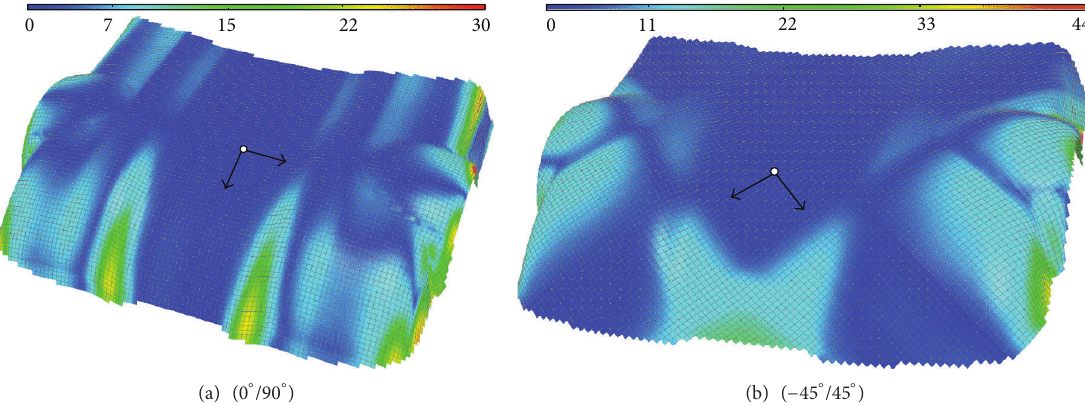
F 10: �soval�es of shear angles bet�een �bres: (a)